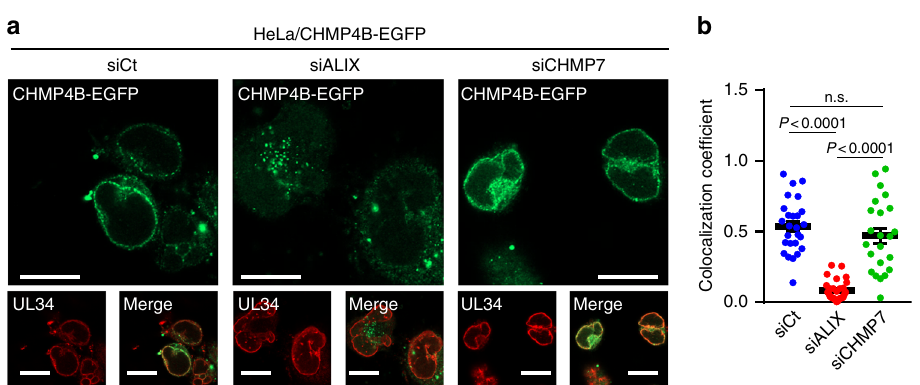
Fig. 5 ALIX is required for the recruitment of ESCRT-III to the NM in HSV-1-infected cells. a Confocal microscope images of HeLa/CHMP4B-EGFP cells treated with (left) control siRNA (siCt), (middle) siRNA to ALIX (siALIX), or (right) siRNA to CHMP7 (siCHMP7) for 48 h and subsequently infected with HSV-1 for 22 h. Bars, 20 μ m. Images are representative of three independent experiments. b Colocalization between CHMP4B-EGFP and UL34 in the experiment in ( a ) was quanti fi ed using Mander ’ s colocalization coef fi cient. Data are shown as the mean ± SEM ( n = 26 for siCt, 29 for siALIX and 23 for siCHMP7, and are representative of three independent experiments). The indicated P -values were obtained using the Tukey ’ s test. n.s., not signi fi cant